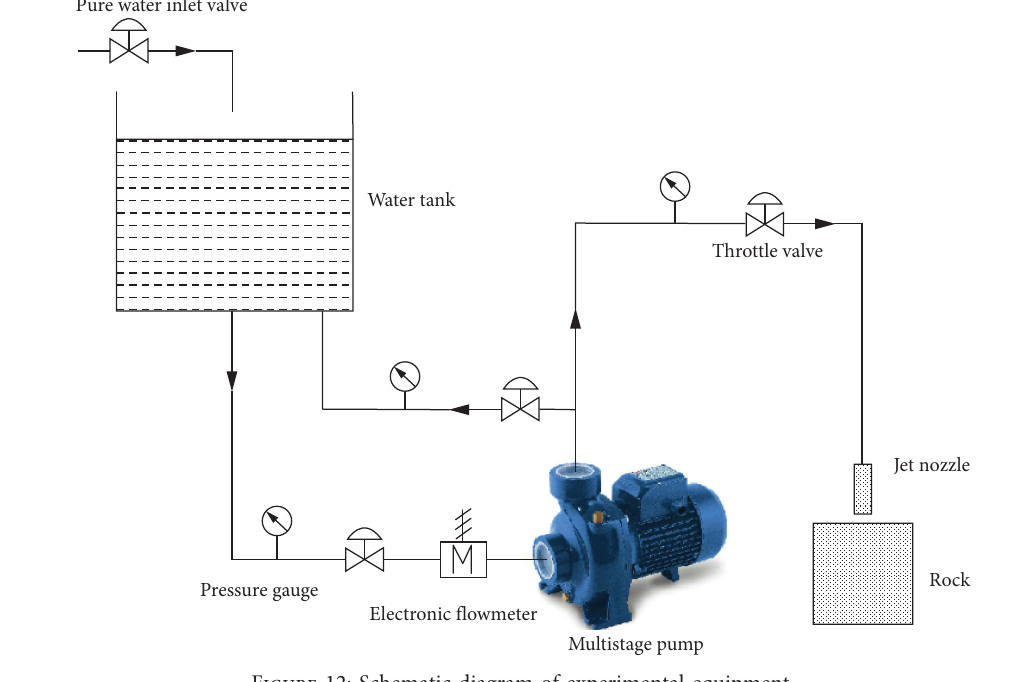
Figure 12: Schematic diagram of experimental equipment.